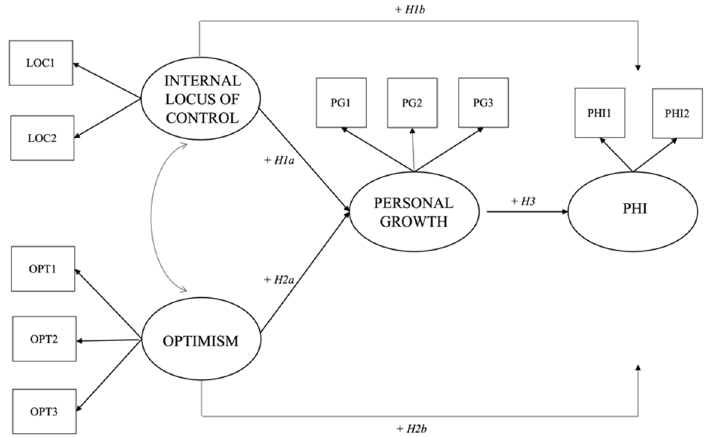
Figure 1. The hypothesized theoretical